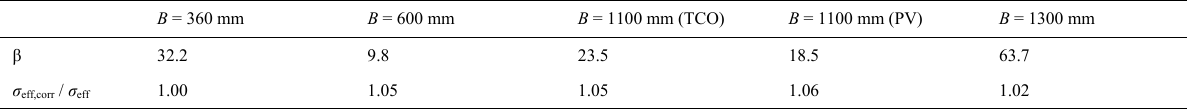
Table 6 determines the overall bending strength values of the PV and TCO specimens using factor k